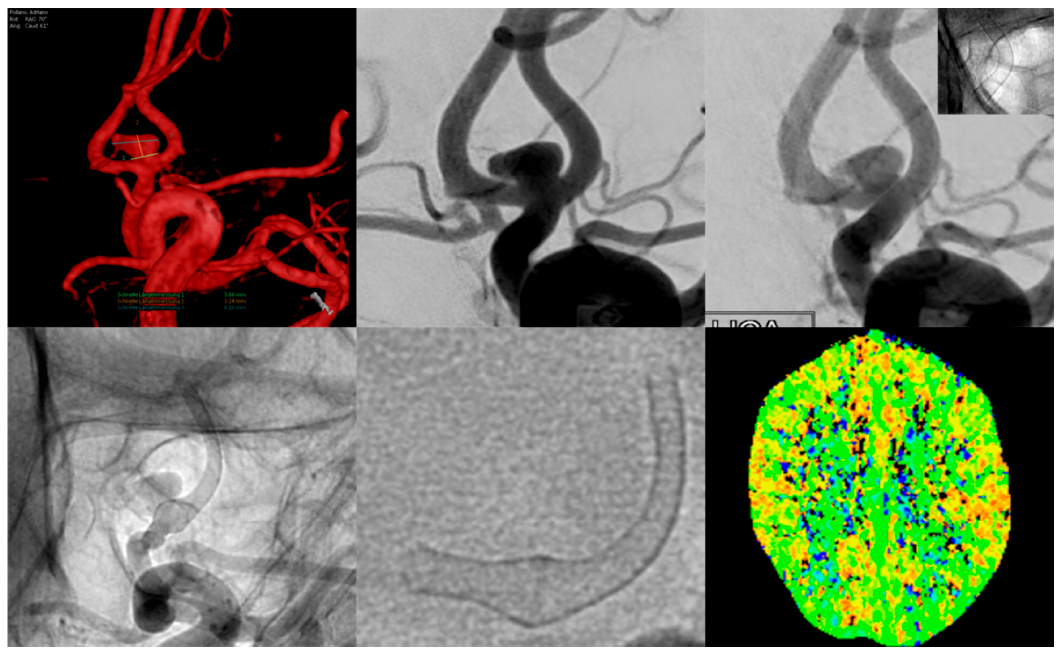
Figure 3. Example of a patient suffering from migraine-type left-sided headache for approximately two weeks, beginning three weeks after flow diverter implantation.The upper row shows a three-dimensional (3D) rotational angiogram (left) and the conventional working projection (middle) of the AcomA-complex with the aneurysm mainly being supplied by the left A1 segment. The right image shows normal calibers of the vessel and FDS after implantation.Inferior row: Conventional, non-subtracted angiogram (left) of the left ICA shows a moderate–high-grade tandem stenosis of the proximal and distal landing zones (A1 and A2 segment of the left ACA) caused by vasospasm. The middle image shows the FDS in free projection; note the normal caliber along the aneurysm-bearing segment and the marked narrowing of the proximal and distal landing zones. CT perfusion imaging (right image) revealed no significant decrease in perfusion of the left ACA territory.